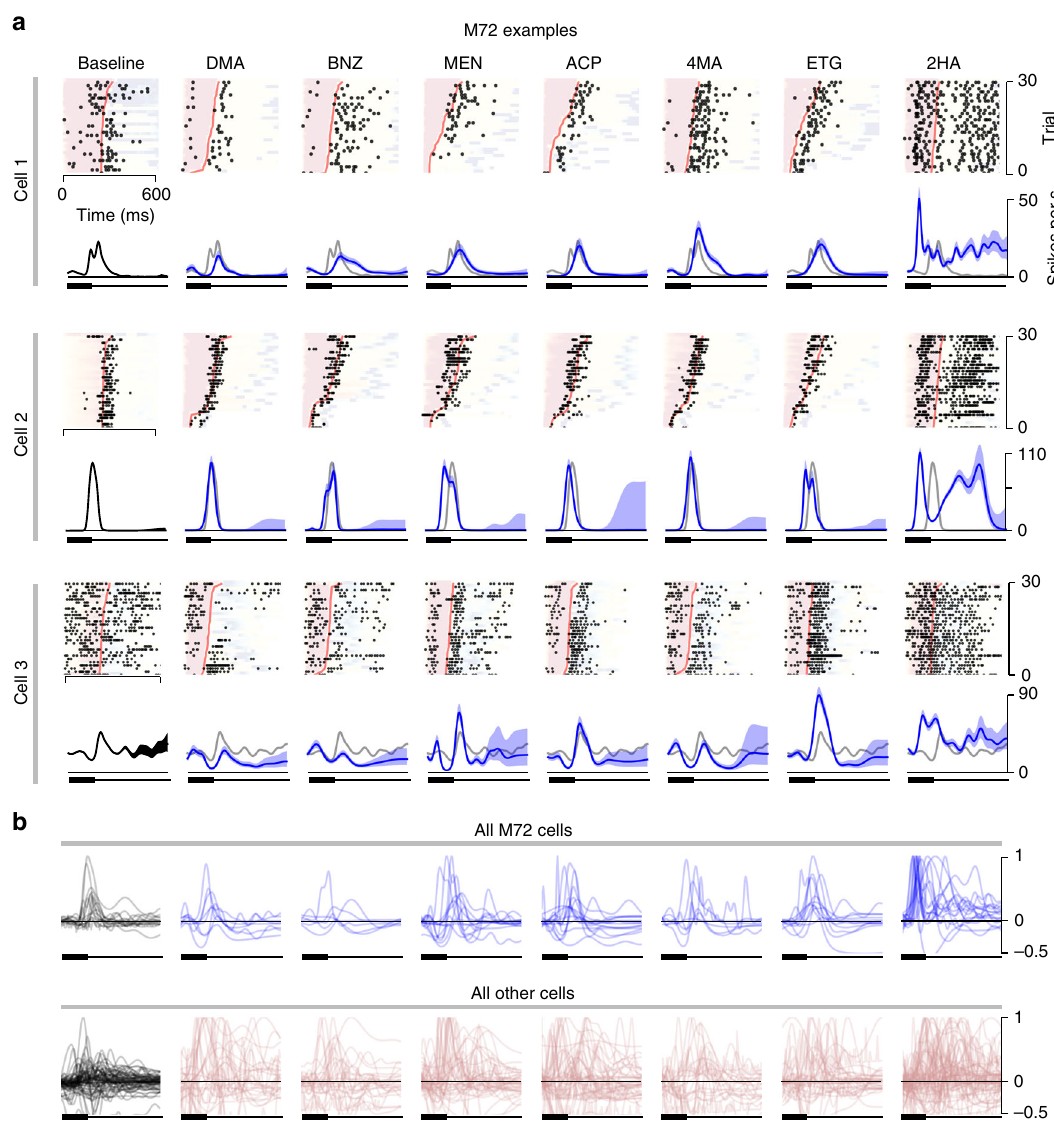
Fig. 3 MT cell responses to odor presentation . a Raster plots and snif fl et estimates for three example M72-MT cells, for each odor (sorted by af fi nity) and baseline conditions. Rasters are shown in real time, as in Fig. 2, for the fi rst sniff of each trial. Trials are sorted by inhalation duration, background color corresponds to sniff phase (as in Fig. 2), and inhalation offset is marked in red. The corresponding snif fl et for each odor and cell (below, blue) was estimated based on the fi rst sniff after odor onset. Baseline snif fl ets ( fi rst column, black) were estimated from activity in the three seconds prior to each odor onset. Baseline snif fl ets are overlaid in gray in each odor panel for comparison. Time axis for snif fl ets as in Fig. 2. b Top row: estimated snif fl ets from all recorded M72-MT cells. The snif fl et of each cell is normalized such that a cell ’ s mean snif fl et value across odors at inhalation onset is zero, and